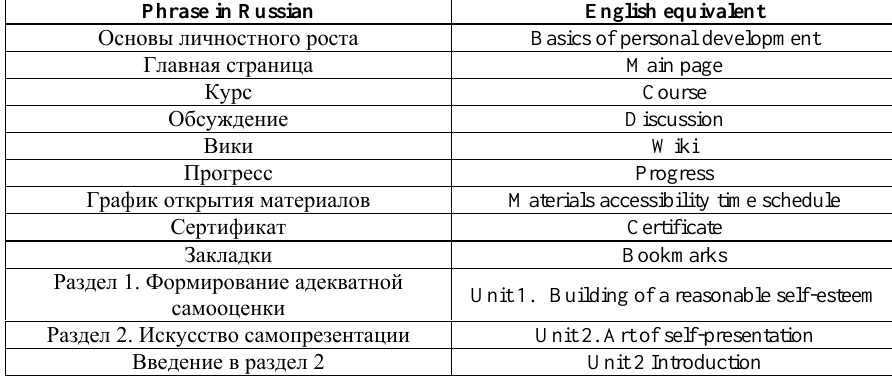
Fig. 1. The «Basics of personal development» course developed by UrFU. Table 1. Contains of Figure